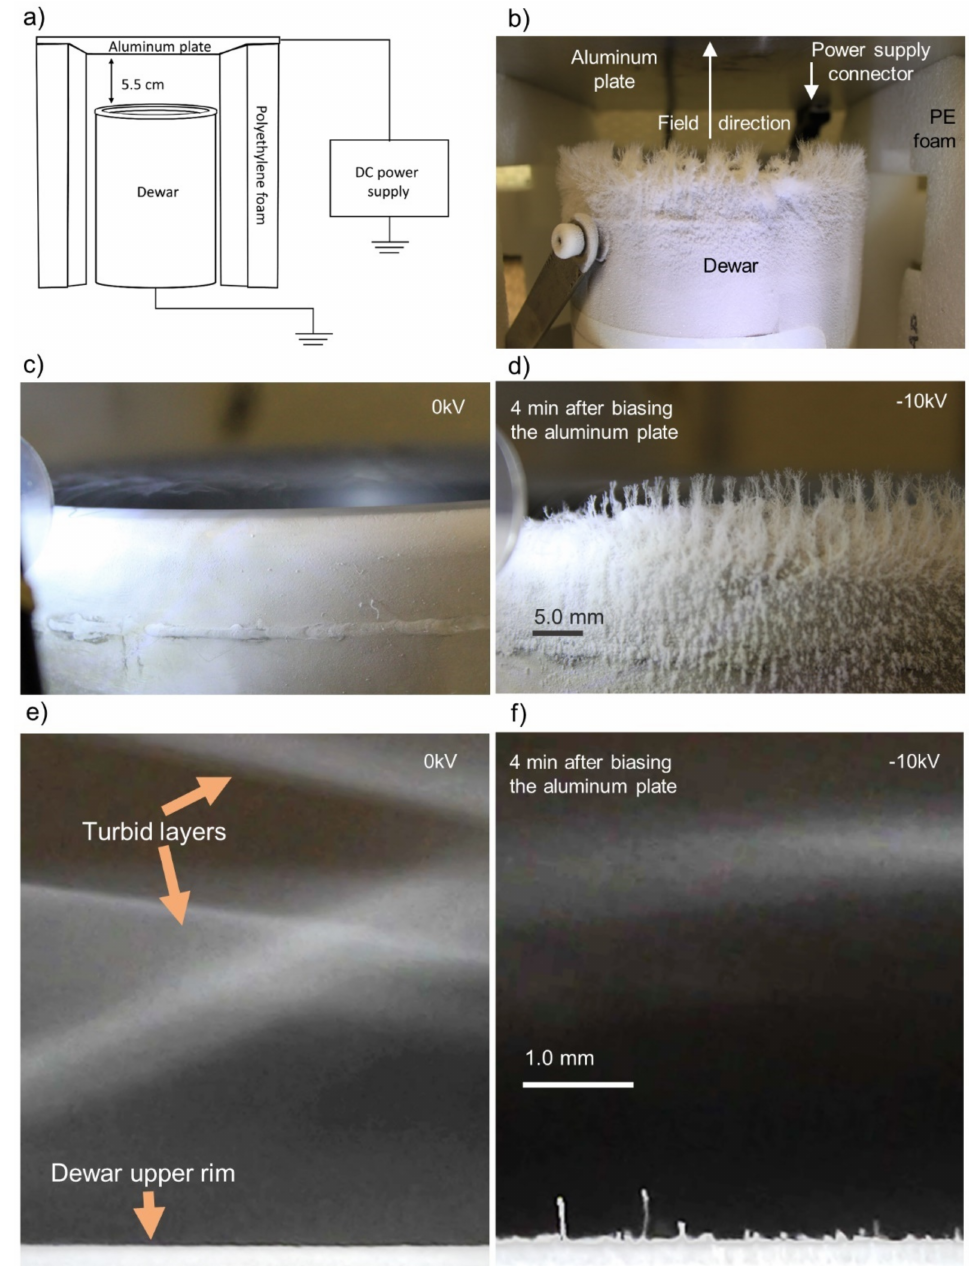
Figure 2. ( a ) Schematic drawing of the experimental arrangement. ( b ) Picture from the experimental set-up, showing the field directly above the Dewar rim. ( c , d ) Frames from the same area, showing needle formation on top of packed ice when the upper electrode (horizontal aluminum plate held 5.5 cm above the Dewar rim) is biased at − 10 kV. Note the mobility of the turbid layer in the gas phase. ( e , f ) Frames from an area under intense lighting, showing needle formation on top of packed ice when the upper electrode (horizontal aluminum plate held 5.5 cm above the Dewar rim) is biased at − 10